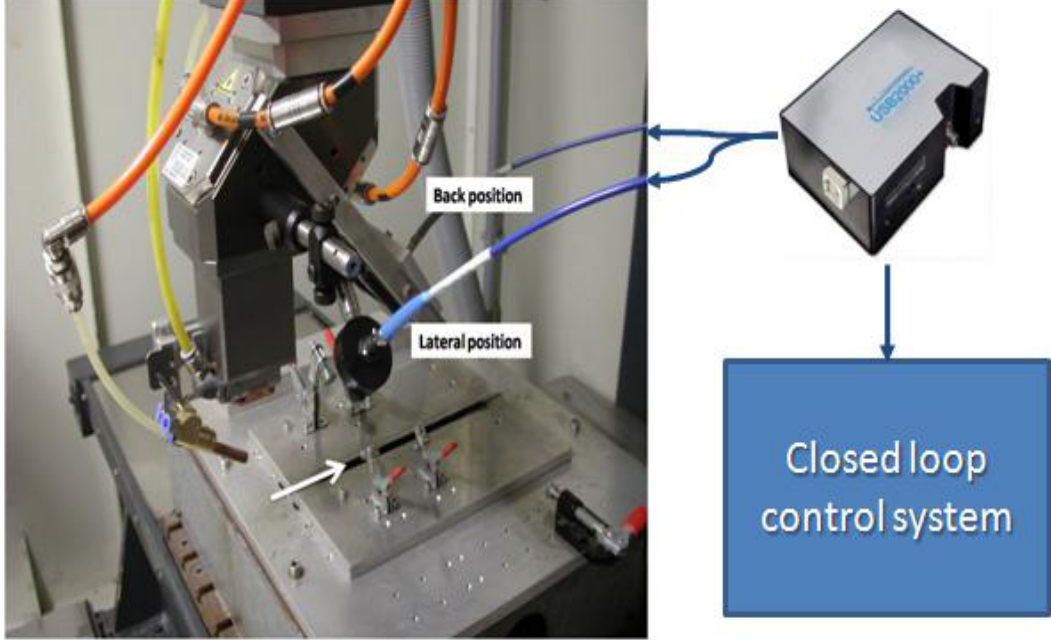
Figure 1. Experimental